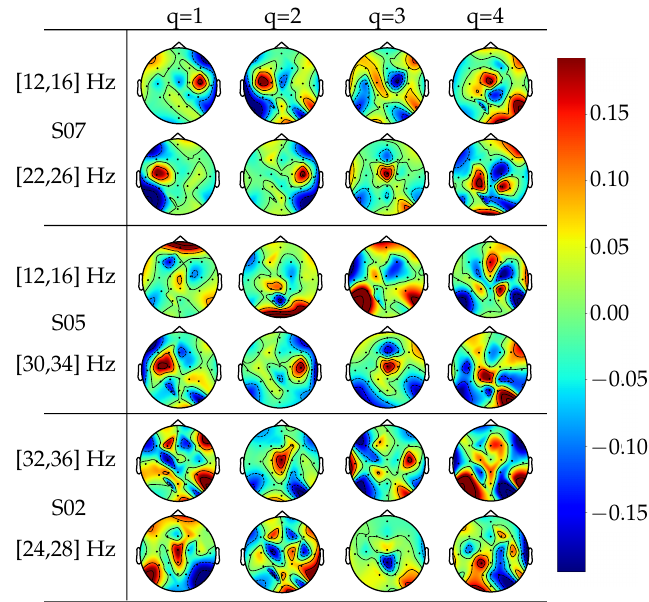
Figure 9. First four spatial patterns of the best performing (S07), worst performing (S02), and most improved (S05) subjects computed from MKSSP. For each subject, the top and bottom row hold the least and most weighted frequency band,